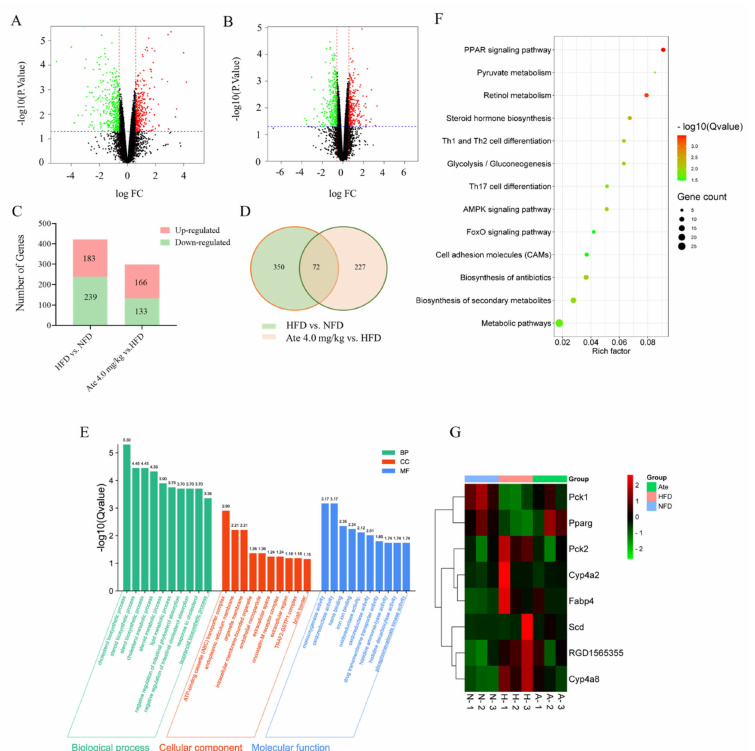
Figure 6. RNA-sequencing analyses of the livers’ DEGs in the NFD, HFD, and Ate 4.0 mg/kg groups. ( A , B ) Volcano diagram of DEGs in the livers between HFD group vs. NFD group and Ate 4.0 mg/kg group vs. HFD group. Red indicates up, green indicates down. ( C ) The numbers of up-regulated (red) and down-regulated (green) DEGs between the HFD group vs. NFD group and Ate 4.0 mg/kg group vs. HFD group. ( D ) Venn diagram of DEGs in between the HFD group vs. NFD group and HFD group vs. Ate 4.0 mg/kg group. ( E ) GO enrichment of those common selected DEGs including the biological process (green), cellular component (red), and molecular function (blue). We displayed the top 10 enrichment pathways of the Q-value in ascending order. ( F ) KEGG pathway enrichment histogram. All date values of the Q-value < 0.05. ( G ) Hierarchical clustering of the expression data for mRNA. Each column represents one sample; rows indicate the TPM of mRNAs. The relative expression of mRNAs is displayed according to the color scale. Green and red denote down-regulation and up-regulation, respectively. All date values of |Log 2 FC|> 0.585, p < 0.05, were accepted as